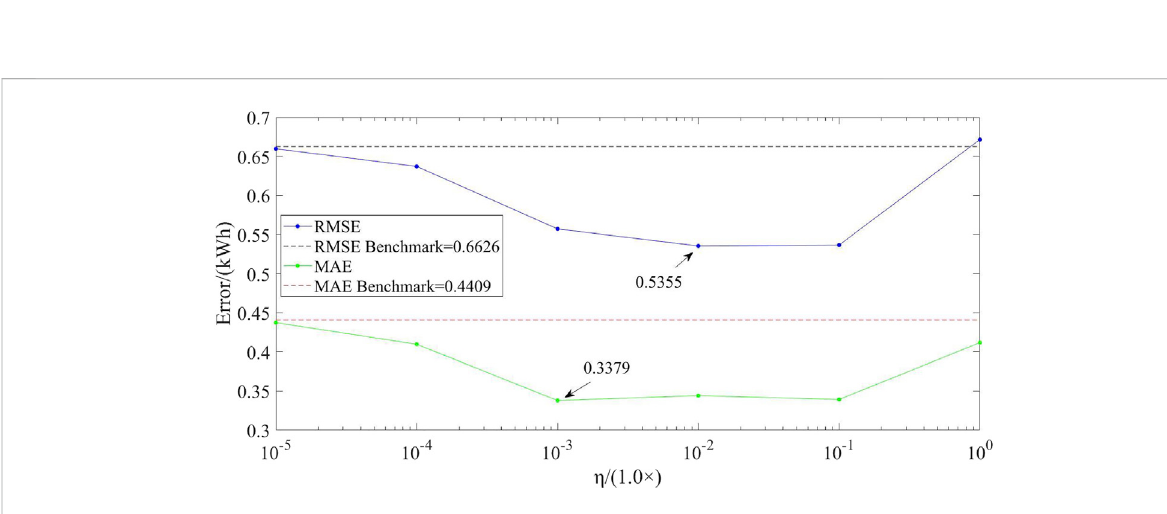
FIGURE 8 Forecasting errors of the proposed method for different values of parameter η (Resident